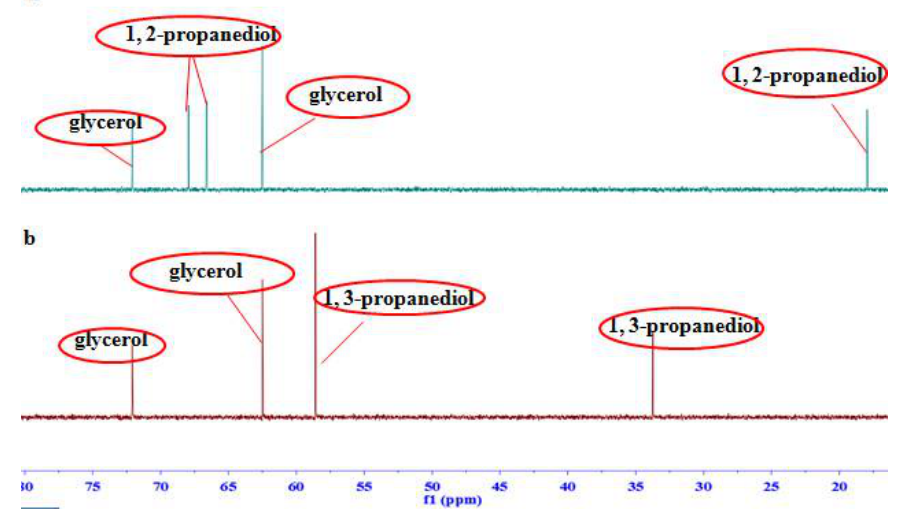
Figure 4. 13 C NMR spectra of ( a ) glycerol and 1,2-propanediol mixture and ( b ) glycerol and 1,3-propanediol mixture.